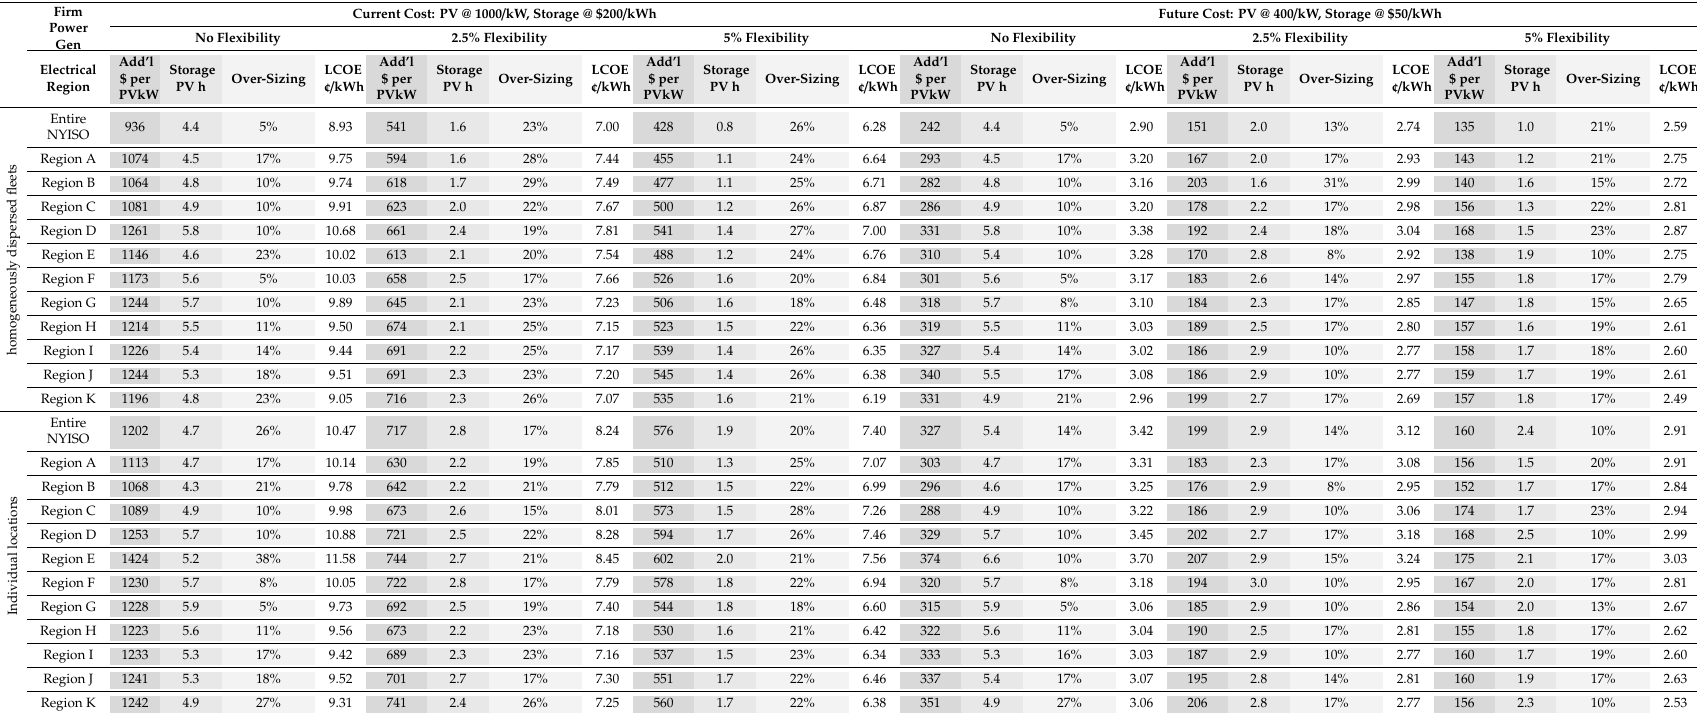
Table 6. Firm generation at 10%